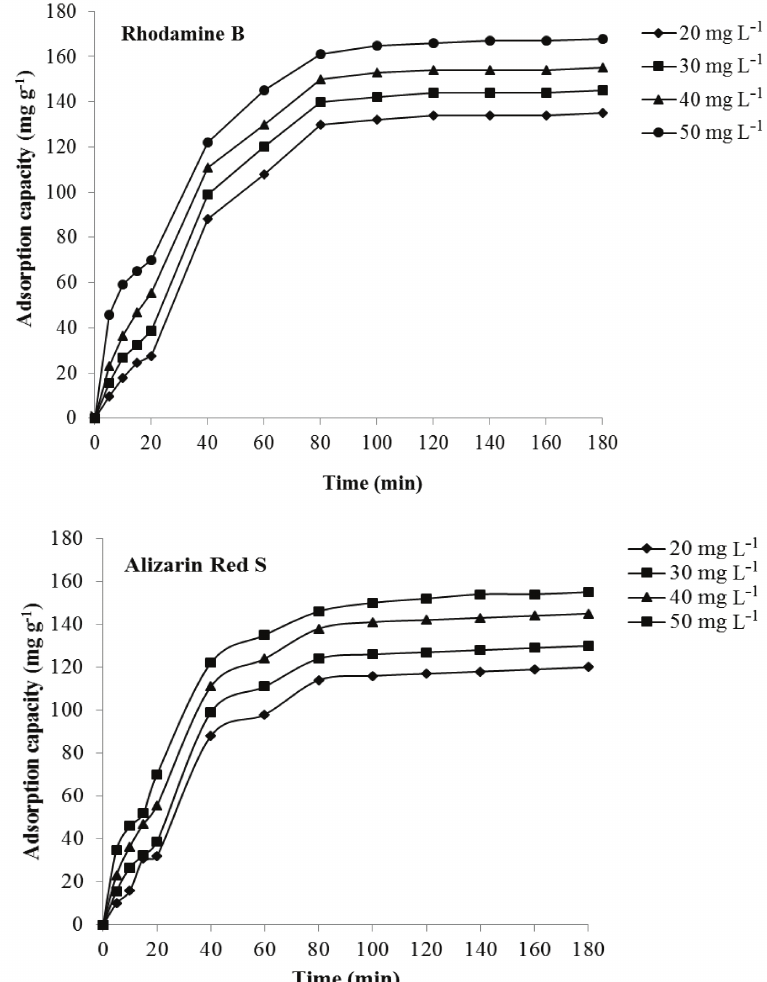
Fig. 4 – Effect of dye concentration on the adsorption capacity (γ = 20 – 50 mg L –1 , adsorbent dosage: 150 mg, temperature: 25 0